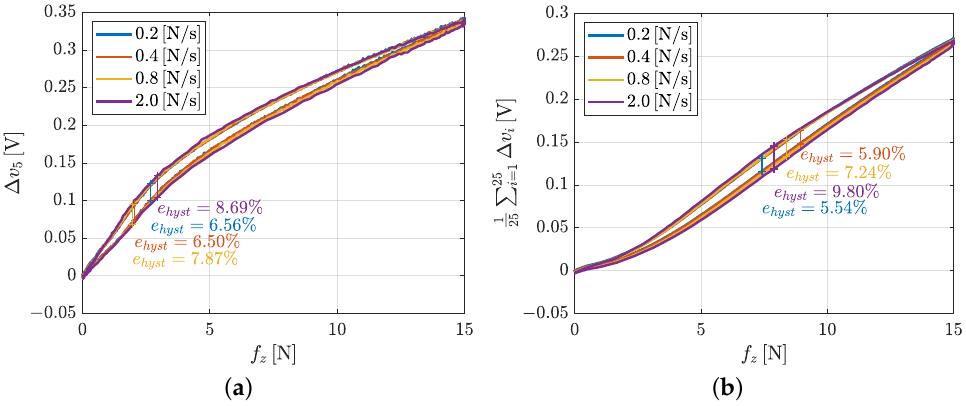
Figure 16. Hysteresis graph for the whole pad characterization: a single voltage ( a ) and mean of voltages ( b ).